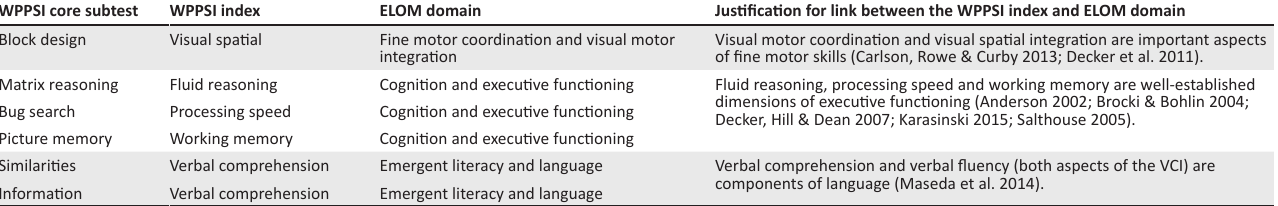
TABLE 3: Early Learning Outcomes Measure and WPPSI-IV comparison. WPPSI core